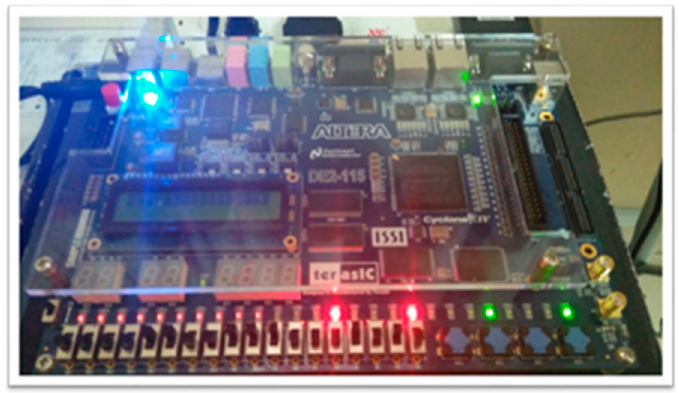
Figure 10. Response text from the language processor.